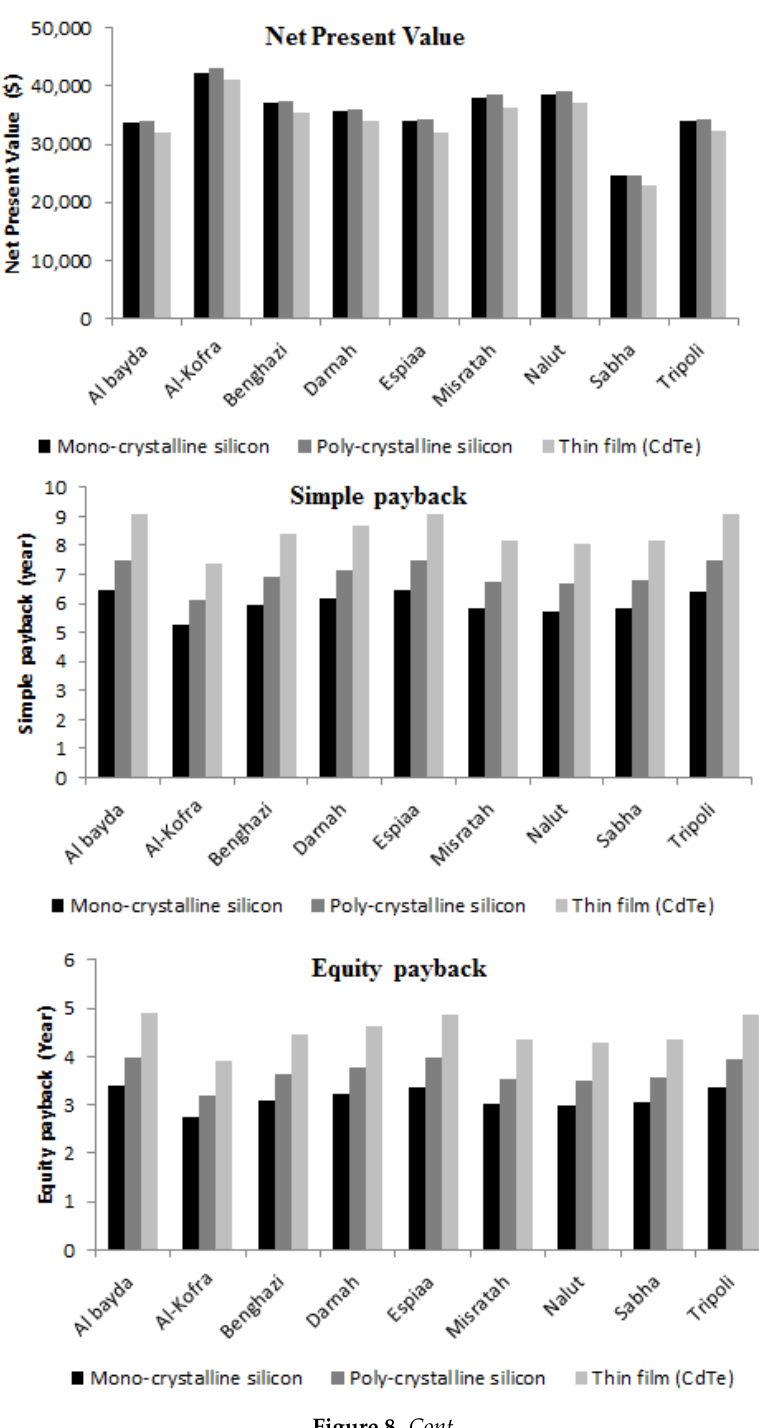
Figure 8. Figure 8. Sensitivity analysis for the 5kW grid-connected solar PV system.